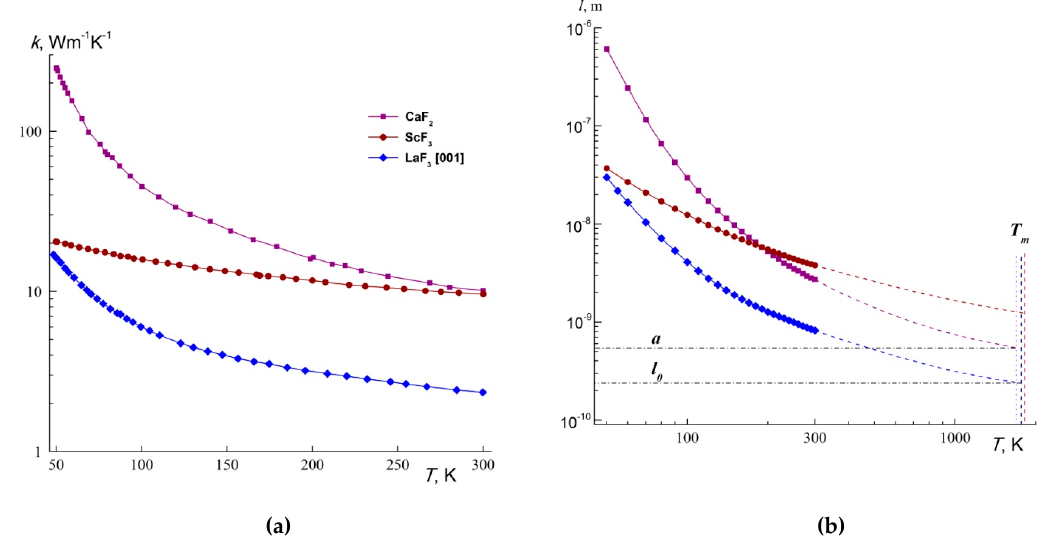
Figure 6. ( a ) Temperature dependences of the thermal conductivity k ( T ) ( a ) and the phonon mean free path l ( T ) ( b ) of CaF 2 , ScF 3 and LaF 3 crystals.